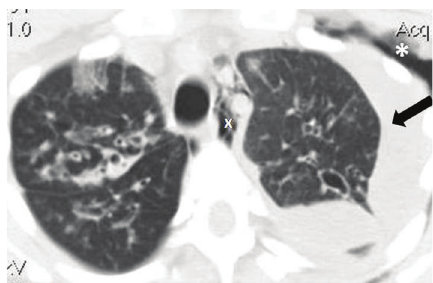
Figure 2: CT scan of the chest demonstrating pleural effusion (arrow), subcutaneous emphysema (asterisk), and pneumomedi- astinum (x). Subcutaneous air and mediastinal air are likely sec- ondary to instrumentation.